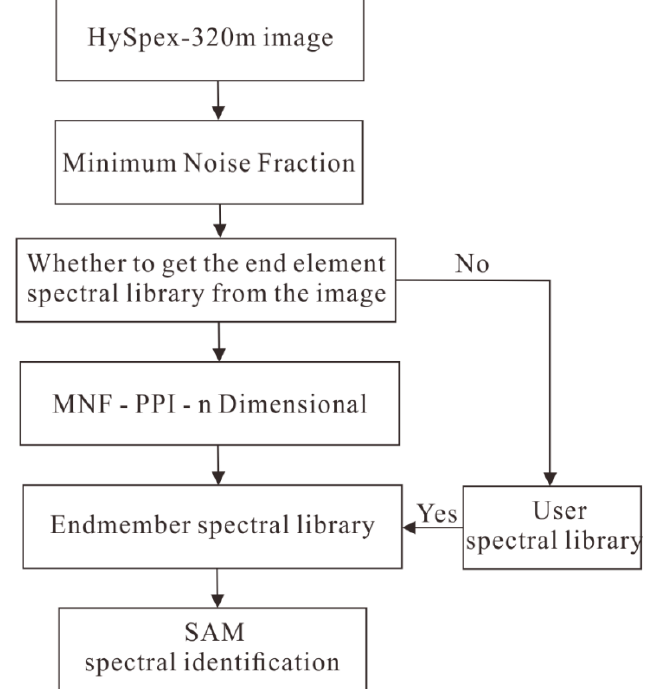
Figure 4. Spectral analysis and identification process.